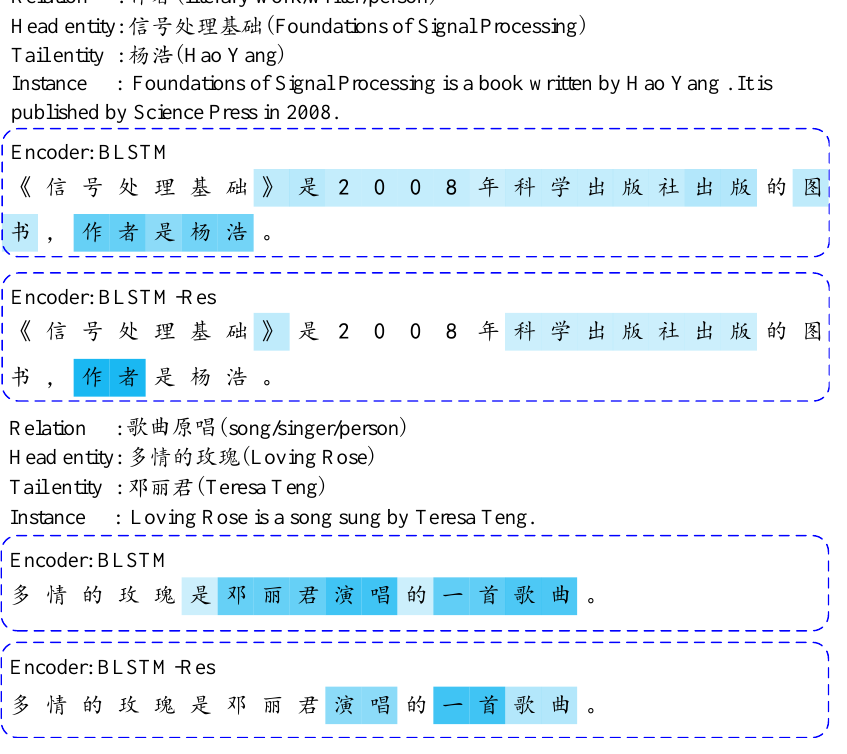
Figure 7. Attention analysis of ‘ 作 者 ’ and ‘ 歌 曲 原 唱 ’